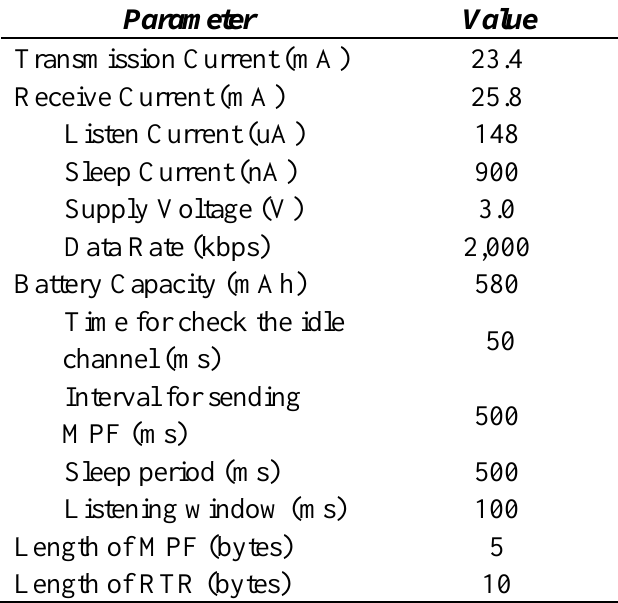
Table 1. Experimental